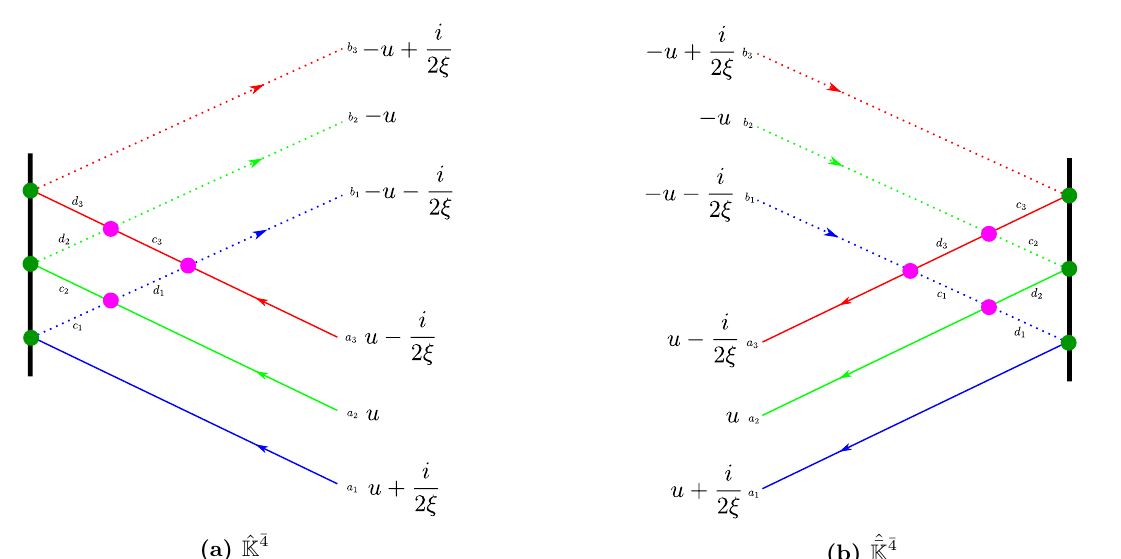
Figure 11. Fusion of the boundary reflection operators to anti-fundamental irrep. ¯4 .